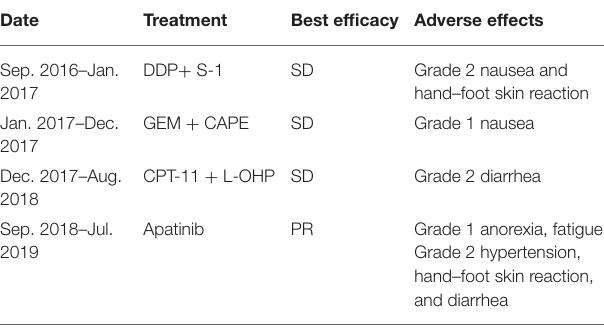
TABLE 1 | Summary of the timeline of the patient’s medical